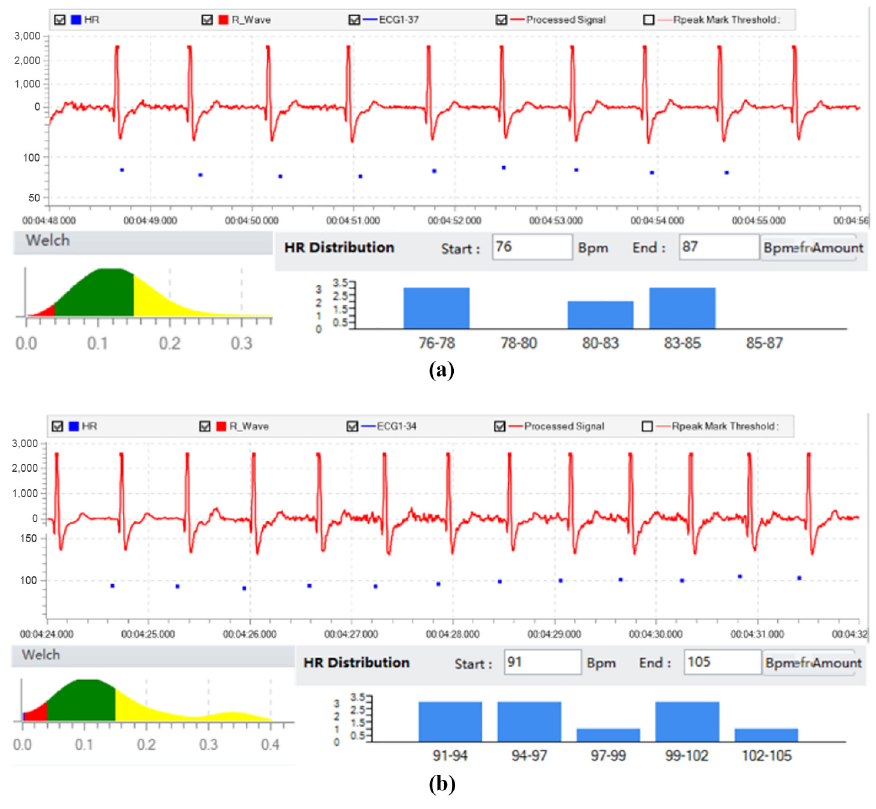
Figure 12 Subjects ’ ECG data during driving in calm and